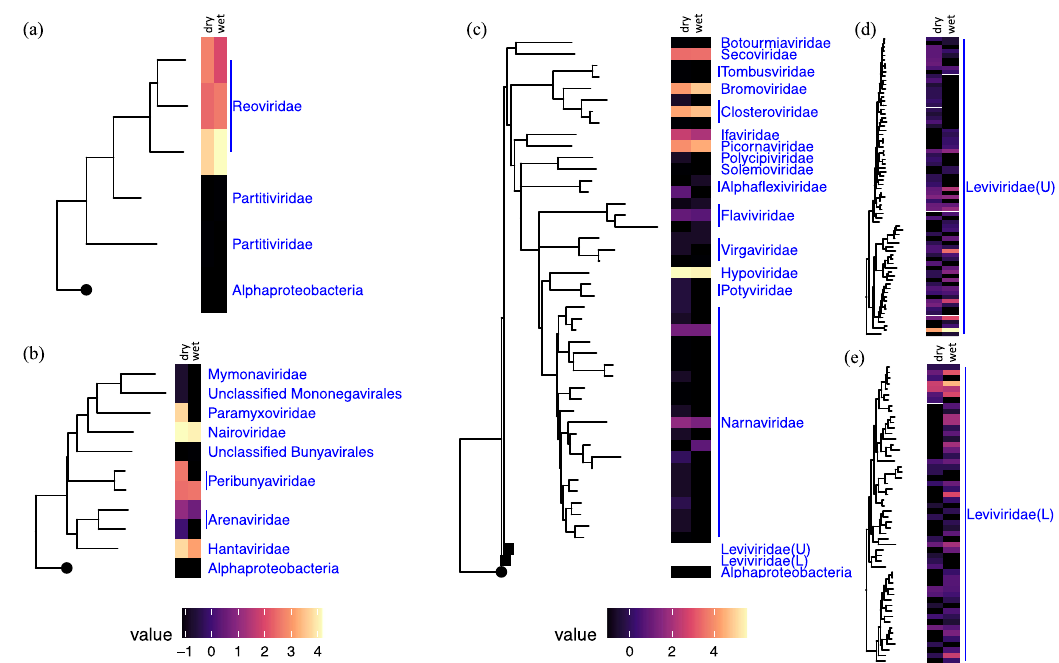
Fig. 4 Phylogenetic diversity of RNA viruses and their estimated abundances. Phylogenetic placement and abundance estimates of the detected: a double-stranded RNA viruses; b negative single-stranded RNA viruses; and c – e positive single-stranded RNA viruses. Each of the RNA viral phylogenetic trees was constructed based on the aligned RNA-dependent RNA polymerase (RdRP) genes assigned to the identi fi ed RNA viral contigs and re-rooted by an RNA-dependent DNA polymerase (APO57079.1) of an Alphaproteobacterium (circular tree node). The abundance estimates for each taxon shown on the tree were measured by taking the average of the estimated average base-coverage per RNA viral contig mapping to this cluster of viruses detected under ‘ dry ’ or ‘ wet ’ conditions (left and right sections of each heatmap, respectively). The abundance estimates for each condition were then log transformed and illustrated in the heatmaps that are aligned to the respective tree tips. Two Leviviridae clades are collapsed in panel ( c ) for ease of visualization (tree nodes in rectangles); upper clade is noted as Leviviridae (U) and lower clade as Leviviridae (L). The phylogenetic structures and the abundance estimates for Leviviridae (U) and Leviviridae (L) are shown in panels ( d ) and ( e ),